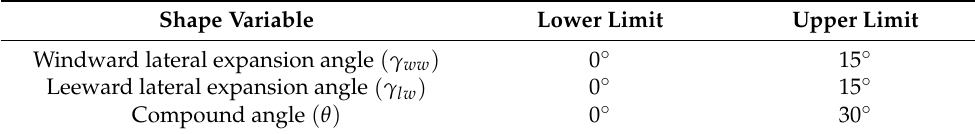
Figure 2. PSP calibration curve. Table 1. Design variables of optimization.